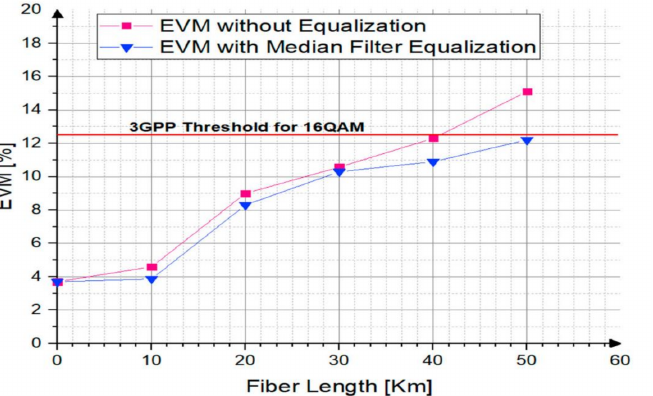
Figure 18. EVM results obtained before and after median filter equalization vs. the fiber lengths for the 16QAM Constellation.